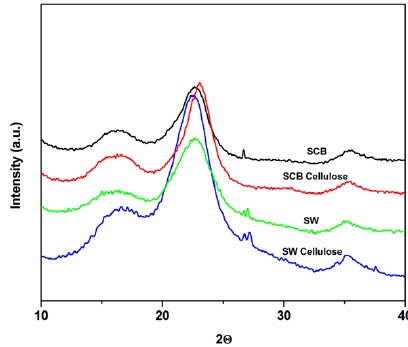
Table 2. Crystallinity index of u SCB, SW, SCB cellulose and SW cellulose.